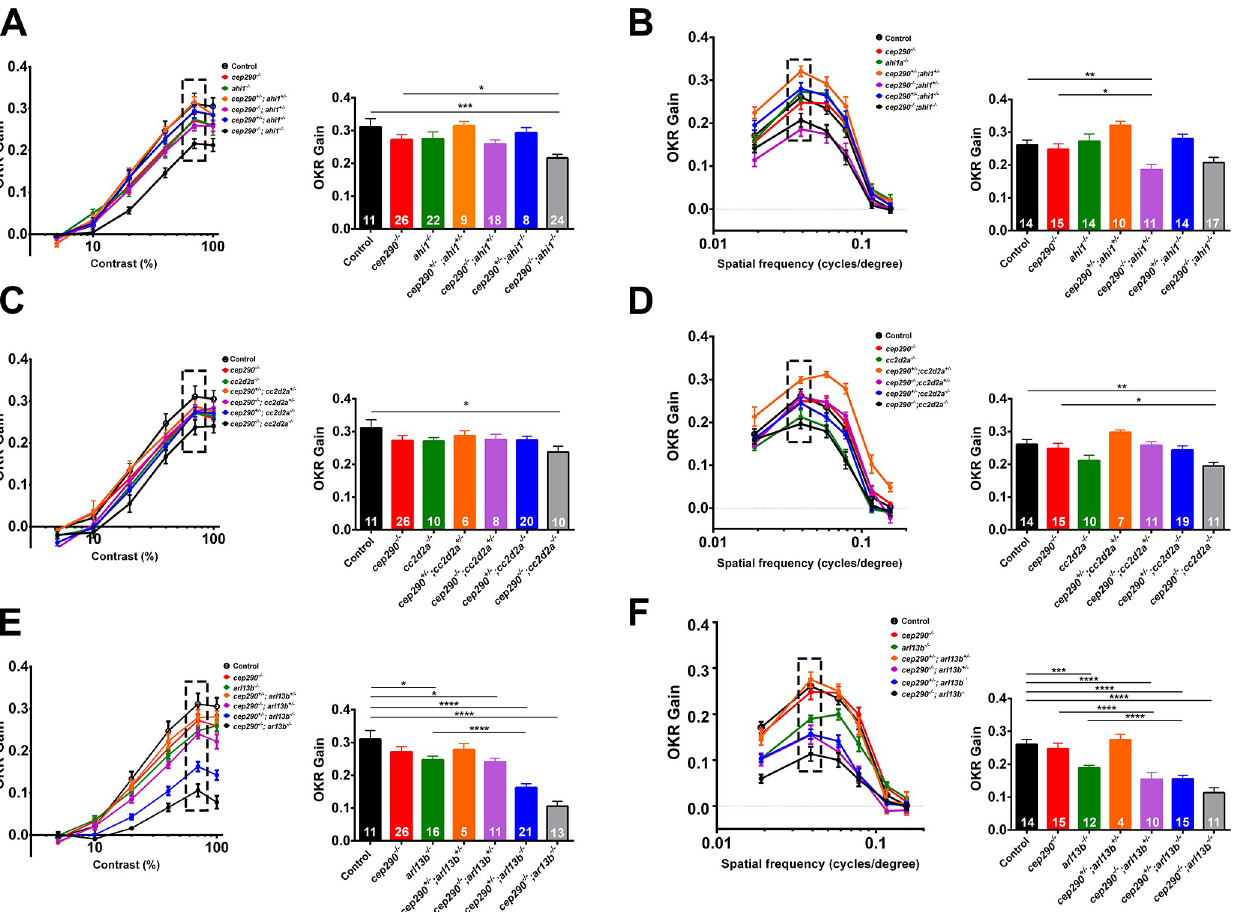
Fig 12. Loss of ahi1 or arl13b impairs visual function of cep290 fh297/fh297 mutants. (A, C, E) OKR contrast response function of 5 dpf larvae (left) and bar graph (right) of corresponding data points at the 70% contrast setting (hatched box). (B, D, F) OKR spatial resolution results of 5 dpf larvae (left) and bar graph of corresponding data points at the 0.039 spatial frequency (hatched box). Genotypes are indicated in the legend and in the X-axes. Inset values indicate the total number larvae tested for each genotype. � P < 0.05; �� P < 0.01; ��� P < 0.001; ���� P < 0.0001 as determined by a 2-way ANOVA with a Multiple Comparisons test and Tukey corrections. Data are presented as means ±